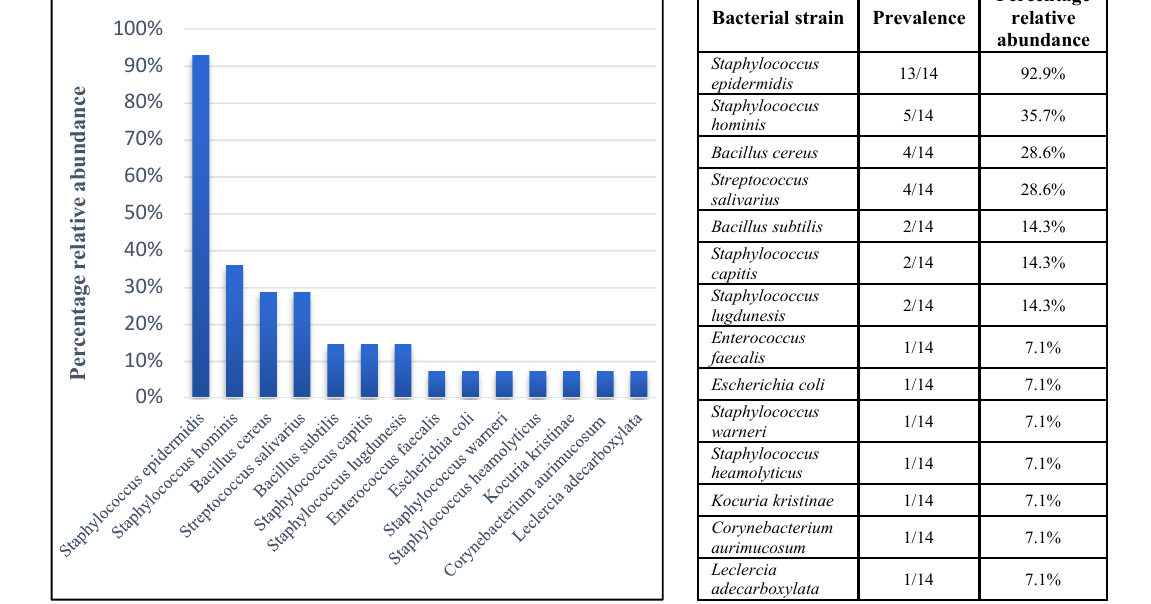
Figure 1. Bacterial strains identified in pumped human milk. Percentage relative abundance represents proportion of samples in which bacterial strain was identified out of overall samples tested ( n = 14). Identification of strains was initially done using the MALDI-TOF Scheme and then through 16S rRNA sequencing analysis. Bacterial strains mentioned were identified with score values > 2.3.